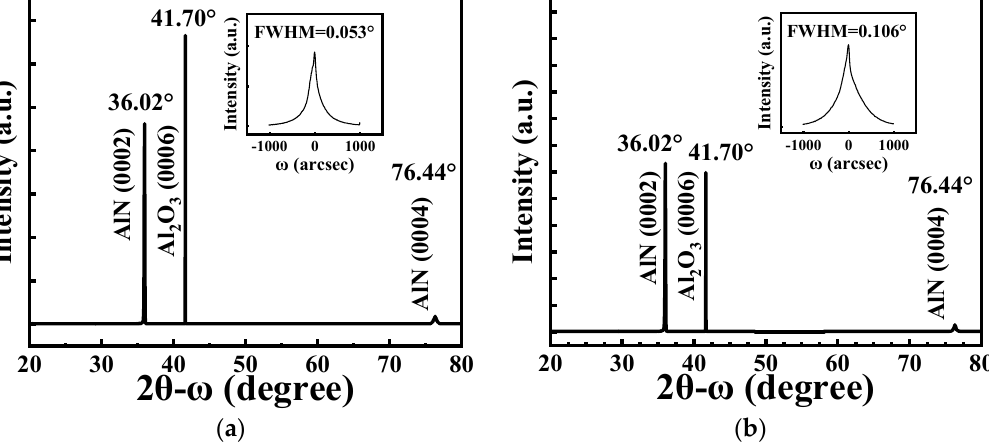
Figure 2. The 2 θ−ω XRD scan patterns of AlN films with thicknesses of ( a ) 0.8 µm and ( b ) 1.2 µm. Figure 2. The 2 θ − ω XRD scan patterns of AlN films with thicknesses of ( a ) 0.8 µ m and ( b ) 1.2 µ m. The inset shows XRD rocking curves of AlN (0002) films. The inset shows XRD rocking curves of AlN (0002)